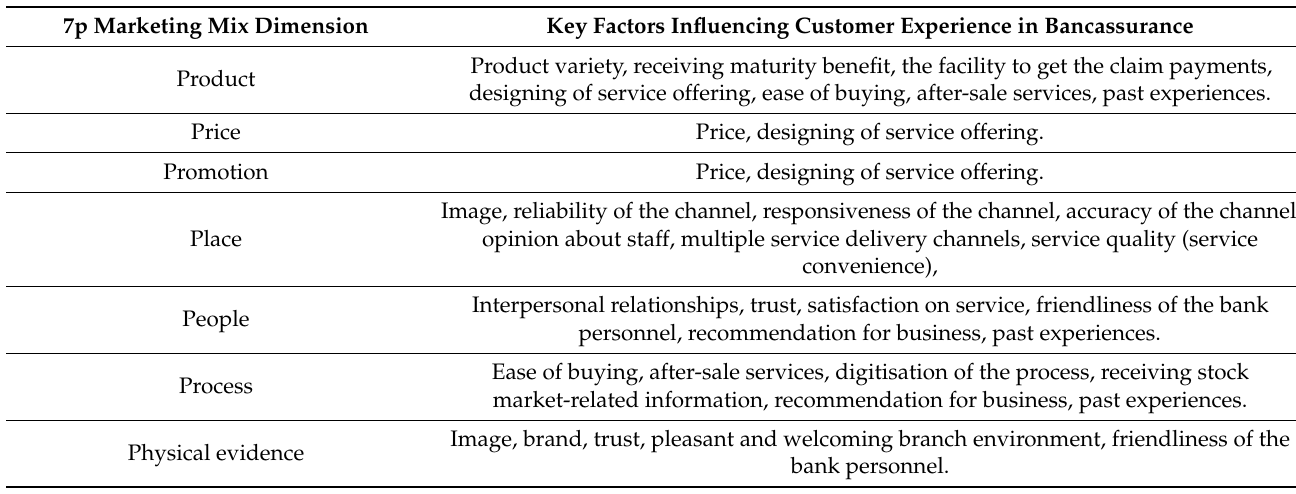
Table 1. Key factors influencing customer experience in bancassurance in the 7p marketing mix dimensions. 7p Marketing Mix